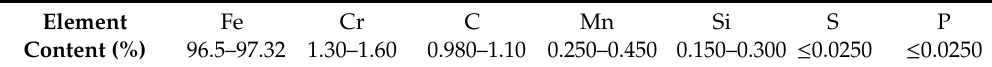
Table 2. Chemical composition of the AISI 52100 steel